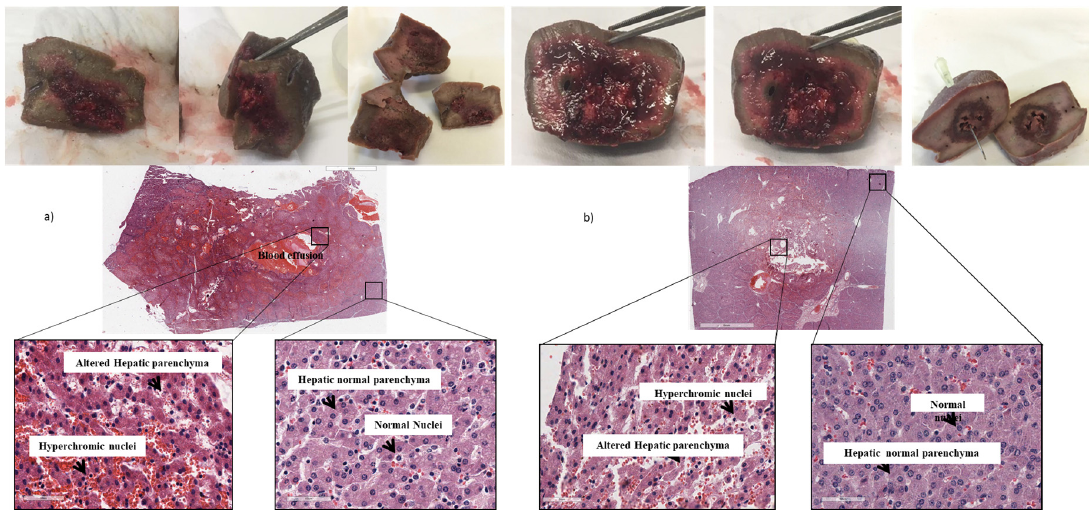
Figure 5. ( a ) Macroscopic images and histological analysis of specimens treated with electrode with zero divergence. ( b ) Macroscopic images and histological analysis of specimens treated with the 4-needle expandable electrode.